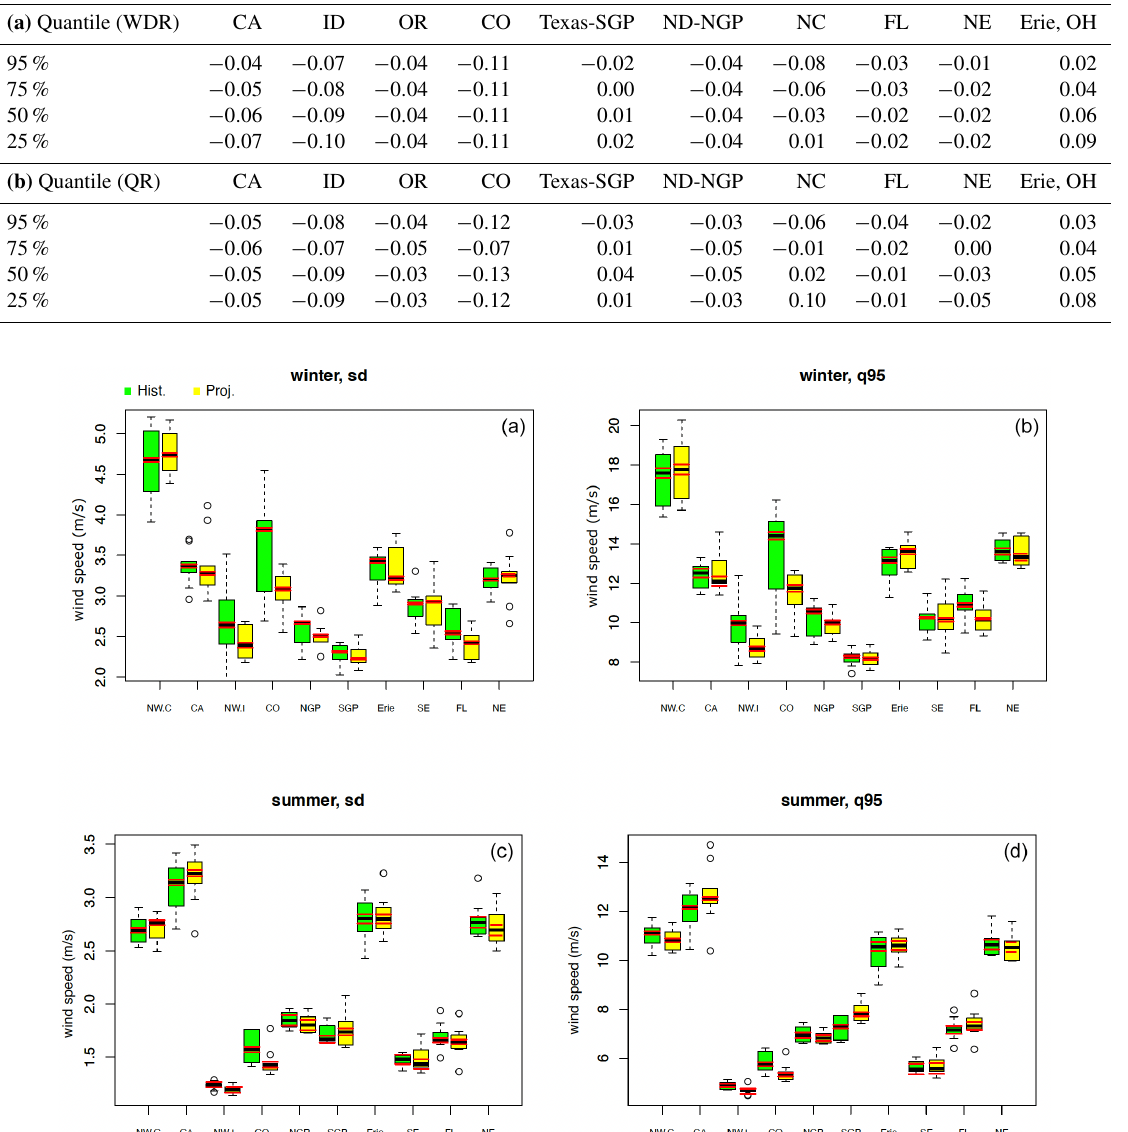
Figure 10. Box plot of the standard deviation (a, c) and 95th quantile (b, d) yearly PCC variability with a corresponding IV in 10 locations from WRF-CCSM. The boxes and whiskers are statistics based on 1 year for 10 years in the historical and future periods, indicating the yearly PCC variability in each 10-year period. The red lines represent the median statistic ± the IV for each location. If the difference between the two means from historic and late century are larger than the IV, then we consider that the future changes in these statistics are robust.